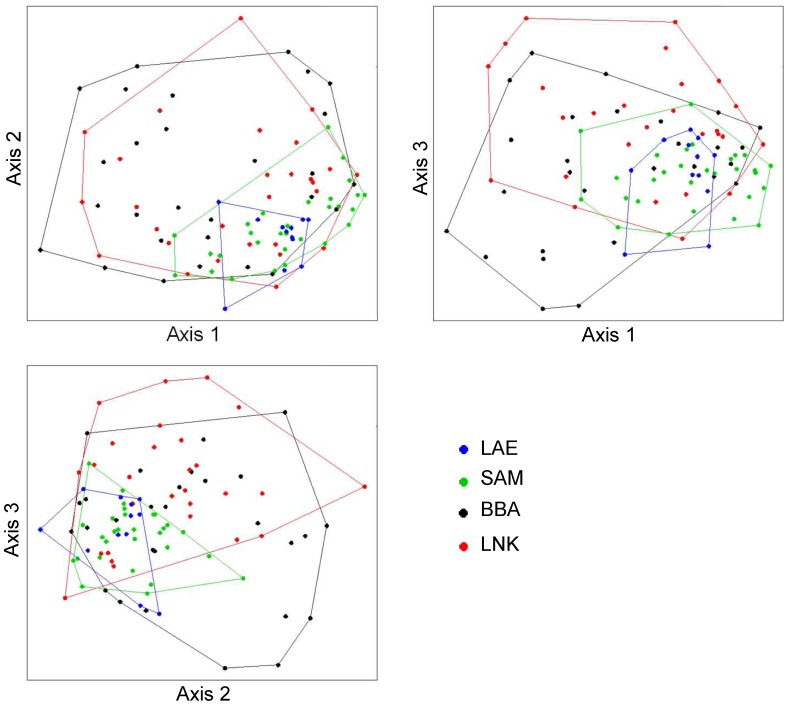
3D non-metric multidimensional scaling (MDS) plot of the Bray-Curtis-based dissimilarity matrix between bacterial communities colonizing the deployed tiles (dots) at the different sites.The colors used for polygons and the samples indicate the geographic positions with near-shore Lae Lae (LAE), near mid-shelf Samalona (SAM), far mid-shelf Bonebatang (BBA) and off-shore Lanyukan (LNK). Stress = 0.175.